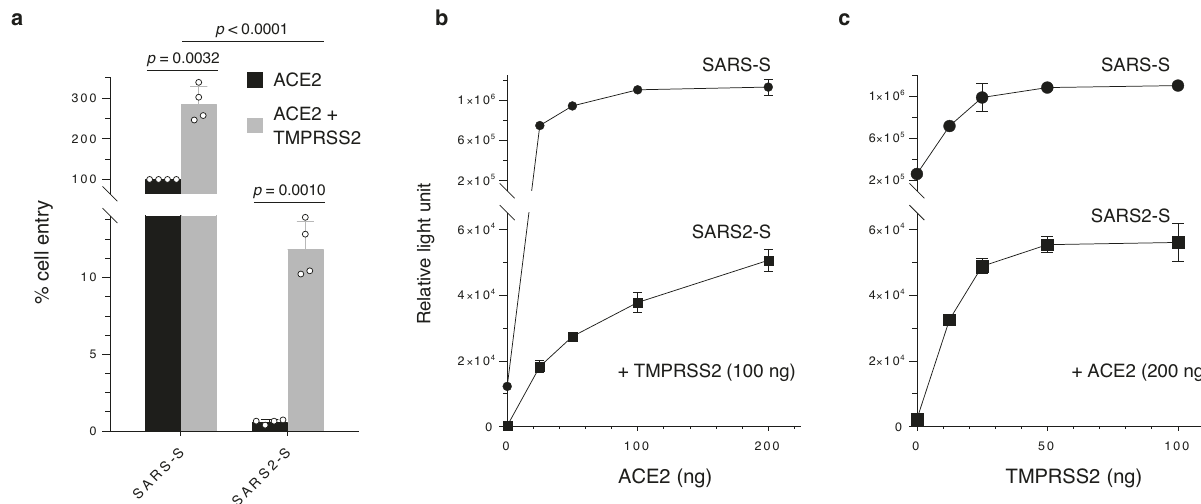
Fig. 1 SARS2-S-mediated cell entry is highly dependent on TMPRSS2. a Viruses were prepared by transfection of 293T cells with the HiBiT-tagged lentiviral packaging plasmid, the fi re fl y luciferase-reporter lentiviral transfer plasmid, and either a SARS-CoV S (SARS-S) or SARS-CoV-2 S (SARS2-S) expression plasmid. Viral supernatants were subjected to HiBiT assays, and S-pseudotyped viruses normalized by HiBiT activity were used for infection of 293T cells expressing the host receptor ACE2 alone (black) or coexpressing TMPRSS2 (gray). Cell entry was determined by fi re fl y luciferase activity in cell lysates. Data from four experiments are shown as a percentage of cell entry of SARS-S-pseudotyped viruses into 293T cells expressing ACE2 only (mean ± s.d., n = 3 technical replicates). The p value was calculated using a two-tailed paired or unpaired Student ’ s t -test. b , c The effect of ACE2 or TMPRSS2 expression levels on cell entry activity. 293T cells were transfected with a high and constant level of an expression plasmid encoding ACE2 together with increasing levels of a TMPRSS2 expression plasmid ( b ), and vice versa ( c ). Transfected cells were infected with lentiviruses pseudotyped with either SARS- S (circle) or SARS2-S (square), as described in a . Data shown are representative of three independent experiments (mean ± s.d., n = 3 technical replicates). Source data are provided as a Source Data fi le.